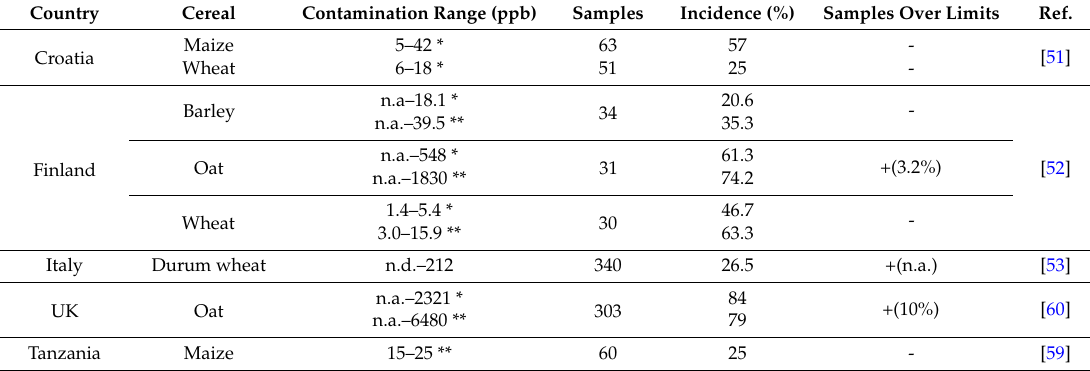
Table 2. Percentage and level of contamination in different countries and commodities relative to T-2 and HT-2 toxins.